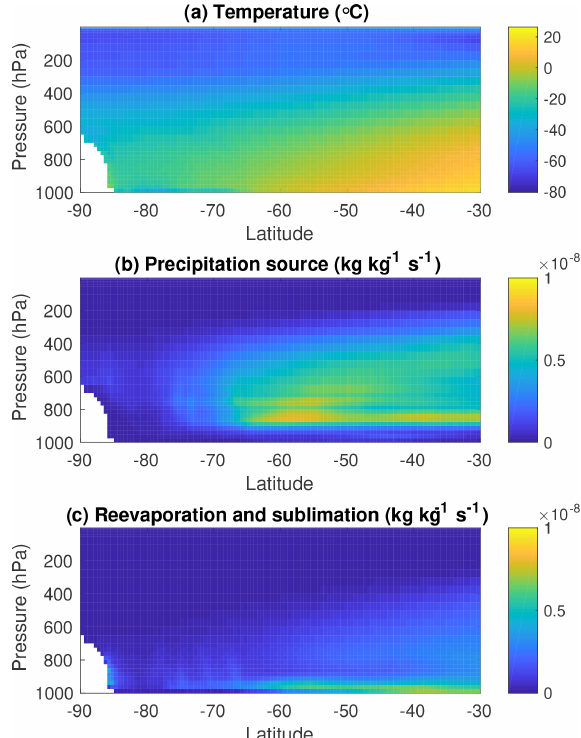
Figure A8. MERRA-2 reanalysis data for 2008–2017. (a) Annual mean zonal-mean air temperature as a function of pressure and lati- tude. (b) Annual mean zonal-mean precipitation source (kilograms of water per kilogram of air per second). (c) Annual mean zonal- mean reevaporation and sublimation of falling precipitation in the same units and color scale as panel (b)